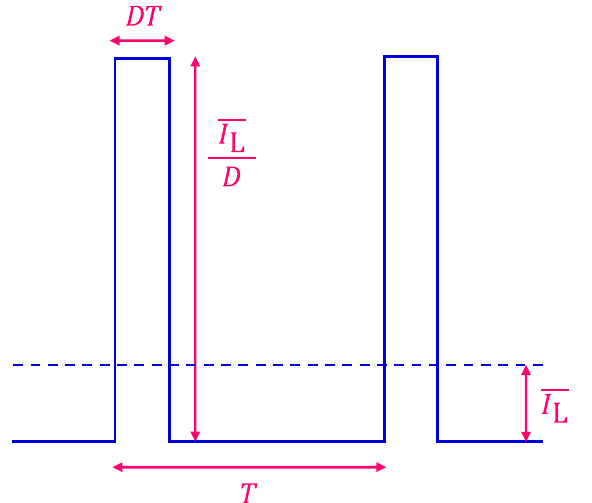
Figure 3. Square wave of I L ( t ) with period ( T ), duty ratio ( D ), and an average LED current ( I L ). Peak pulse height is I L / D